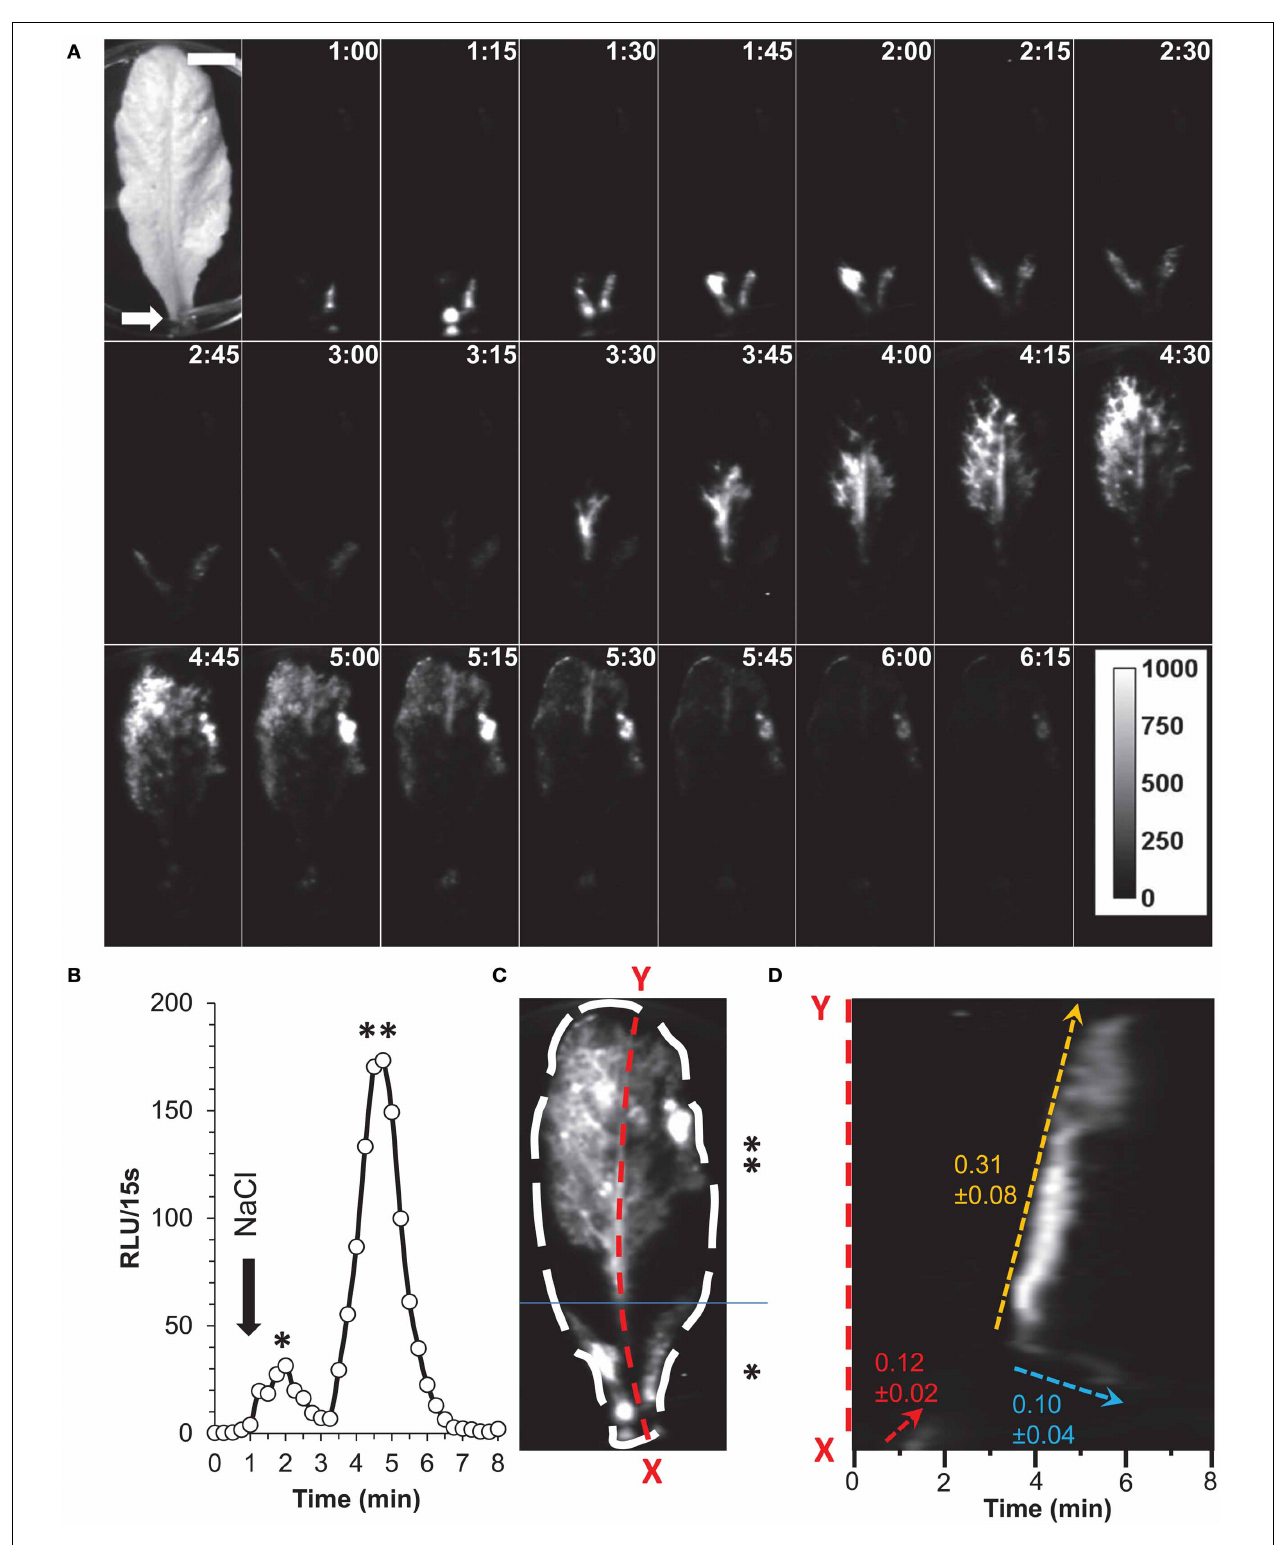
FIGURE 8 | Salt application on detached leaf elicits Ca 2 + waves along the vascular tissue. (A) Time series of images (time of capture indicated in the right top corner of each image in min:s) showing propagation of Ca 2 + responses in a detached leaf. First image of the series is a bright-field view of